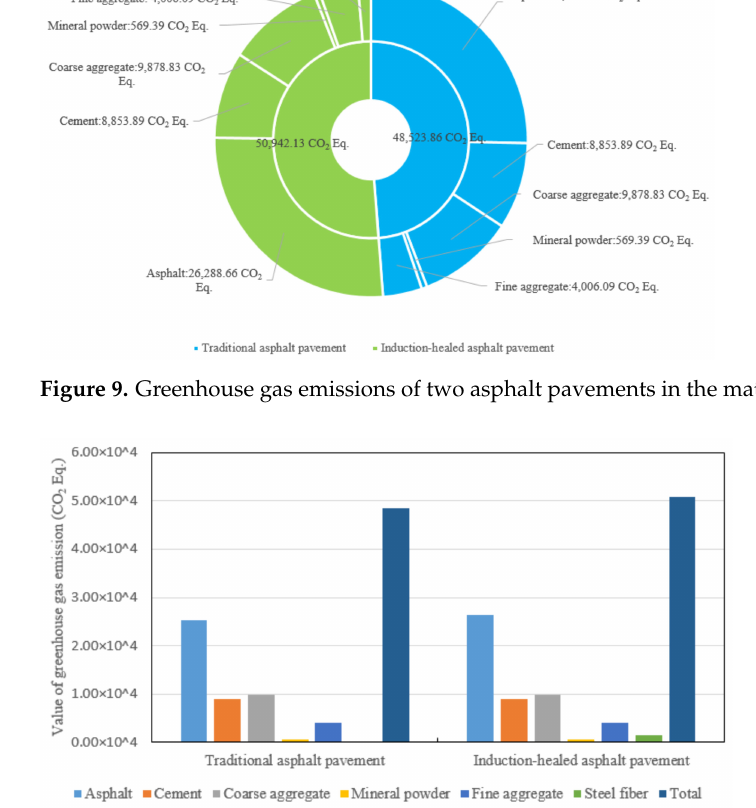
Figure 10. Fluctuation chart of greenhouse gas emissions of two asphalt pavements in the material manufacturing stage.